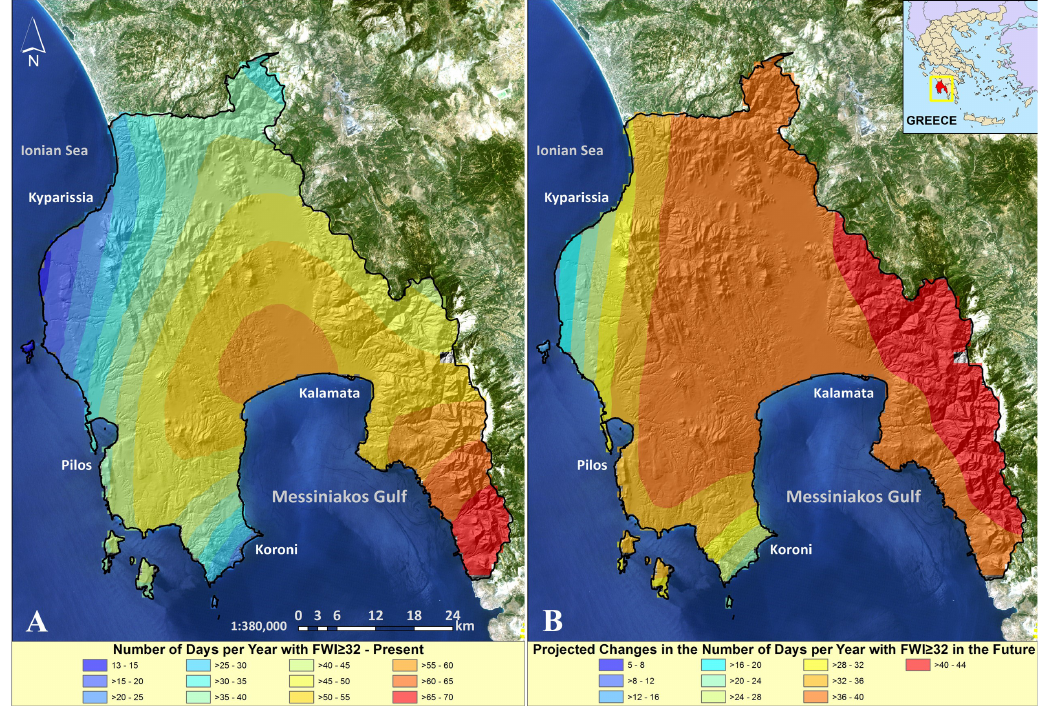
Figure 4. ( A ) Number of days per year with extreme fire risk (FWI ≥ 32) in the present climate and ( B ) projected changes in the number of days per year with extreme fire risk between the future and the present climate in Messinia,